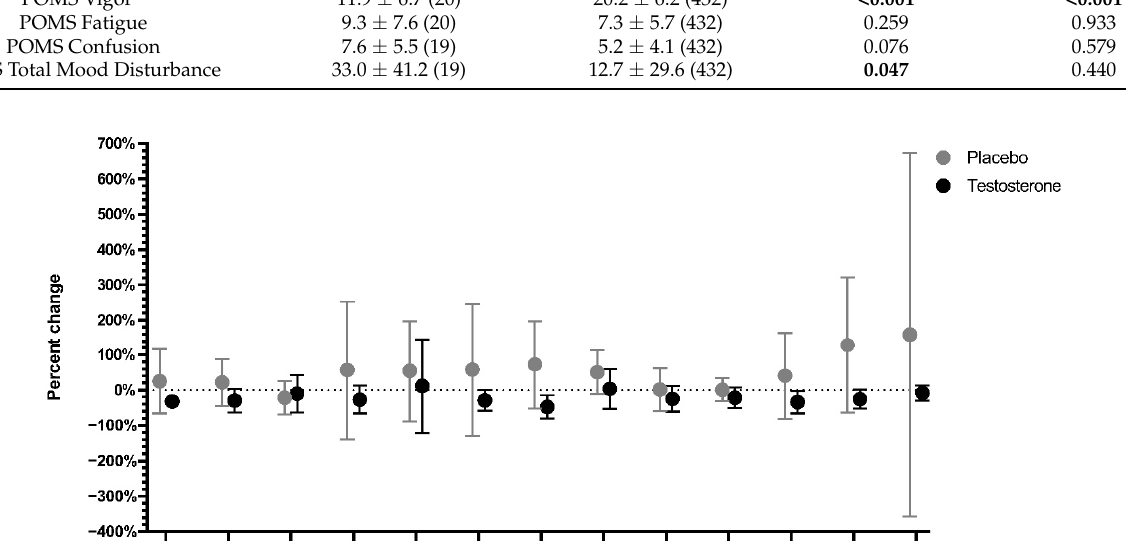
Figure 3. Percent change (average ± SD) in serum cytokine concentrations from baseline to post- treatment for cancer patients receiving testosterone ( n = 7) or placebo (n = 11). There were no significant differences between groups after correcting for multiple testing. Abbreviations: GM- CSF—granulocyte-macrophage colony-stimulating factor, IFN- γ —interferon-gamma, IL—interleukin, tumor necrosis factor—TNF- α